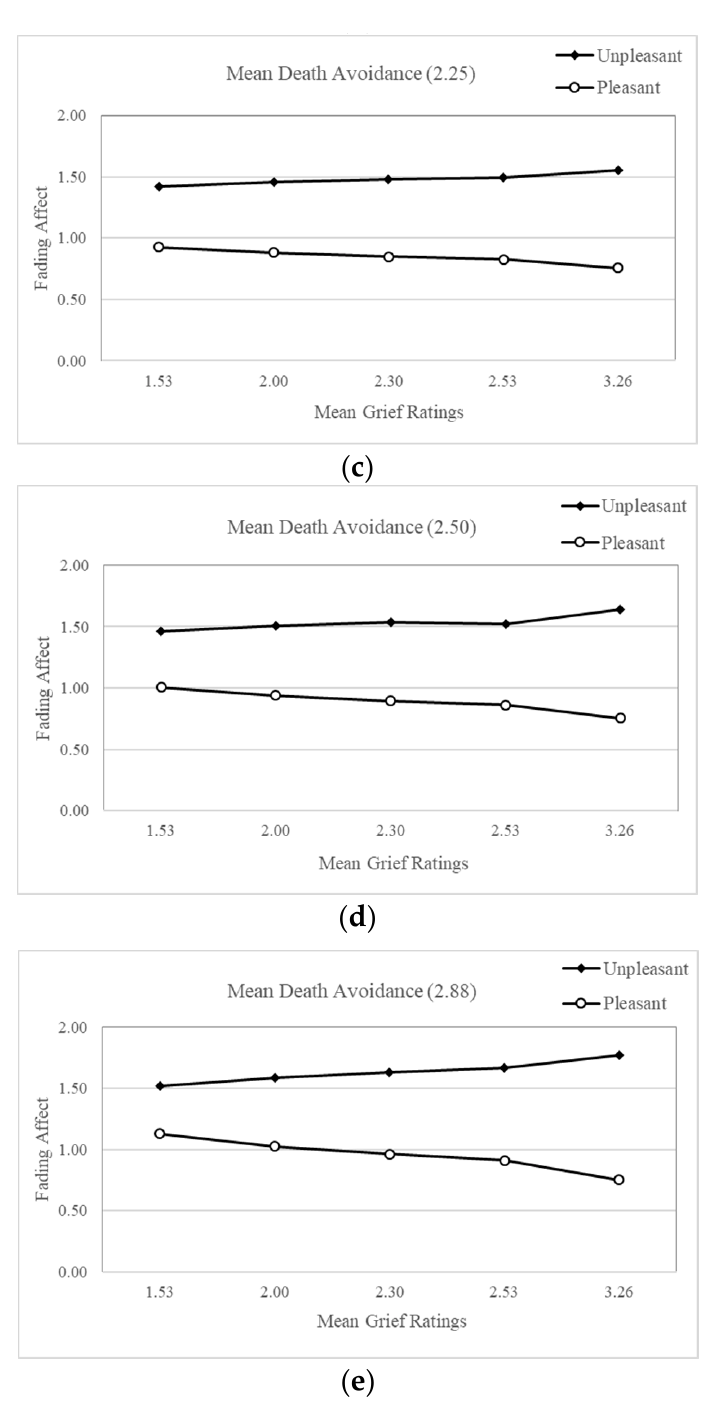
Figure 6. ( a ) Fading affect for initial event affect across quintile levels (10th through 90th) of grief ratings for events at mean avoidant death attitudes of 1.630 for events; ( b ) Fading affect for initial event affect across quintile levels (10th through 90th) of grief ratings for events at mean avoidant death attitudes of 2.000 for events; ( c ) Fading affect for initial event affect across quintile levels (10th through 90th) of grief ratings for events at mean avoidant death attitudes of 2.252 for events; ( d ) Fading affect for initial event affect across quintile levels (10th through 90th) of grief ratings for events at mean avoidant death attitudes of 2.500 for events; ( e ) Fading affect for initial event affect across quintile levels (10th through 90th) of grief ratings for events at mean avoidant death attitudes of 2.880 for events. Table 3. Fading Affect Bias Regression Coefficients (SE) across Quintiles (Mean Rating) of Grief and Avoidant Death Attitudes Ratings (large positive coefficients represent large FAB).